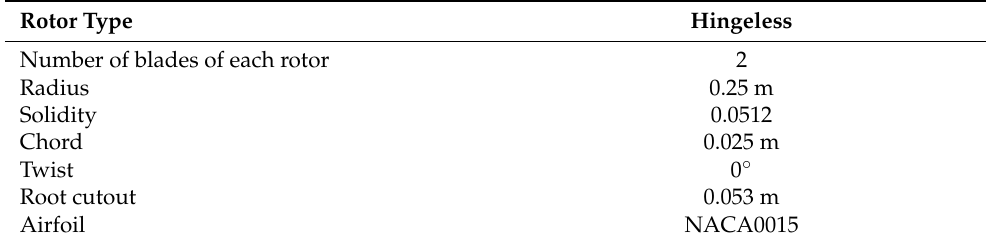
Table 1. Properties of the test